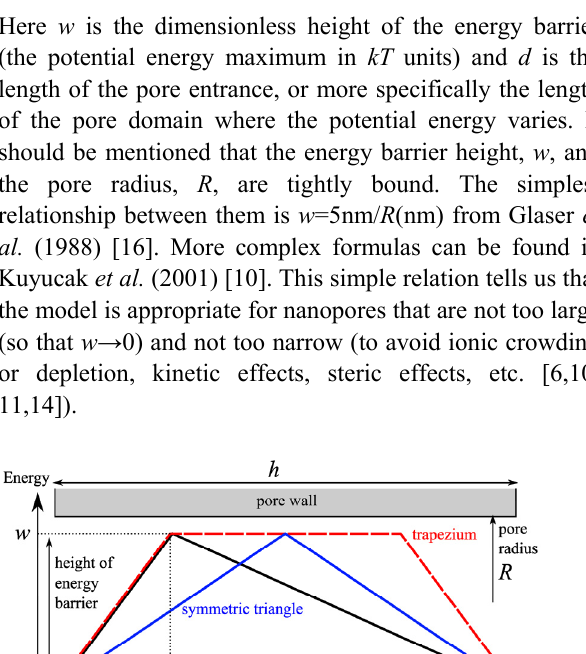
Fig. 1: Schematic representations of the three assumed profiles for the ion potential energy inside a pore: asymmetric triangular (black line); symmetric triangular (blue line); and trapezoidal (broken red